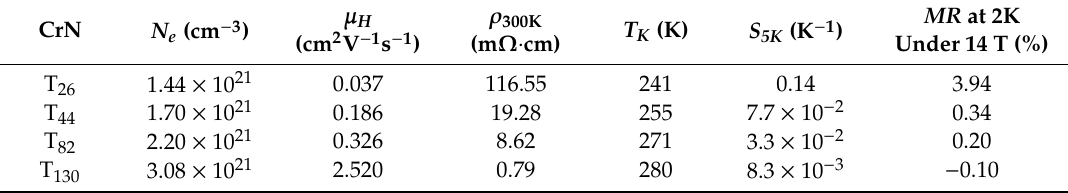
Table2. TheelectricaltransportandmagnetoresistanceparametersofCrNthinfilms. (Carrierconcentration N e , mobility µ H , resistivity at 300 K ρ 300K , transformation temperature T K , zero-field sensitivity at 5K S 5K , magnetoresistance MR